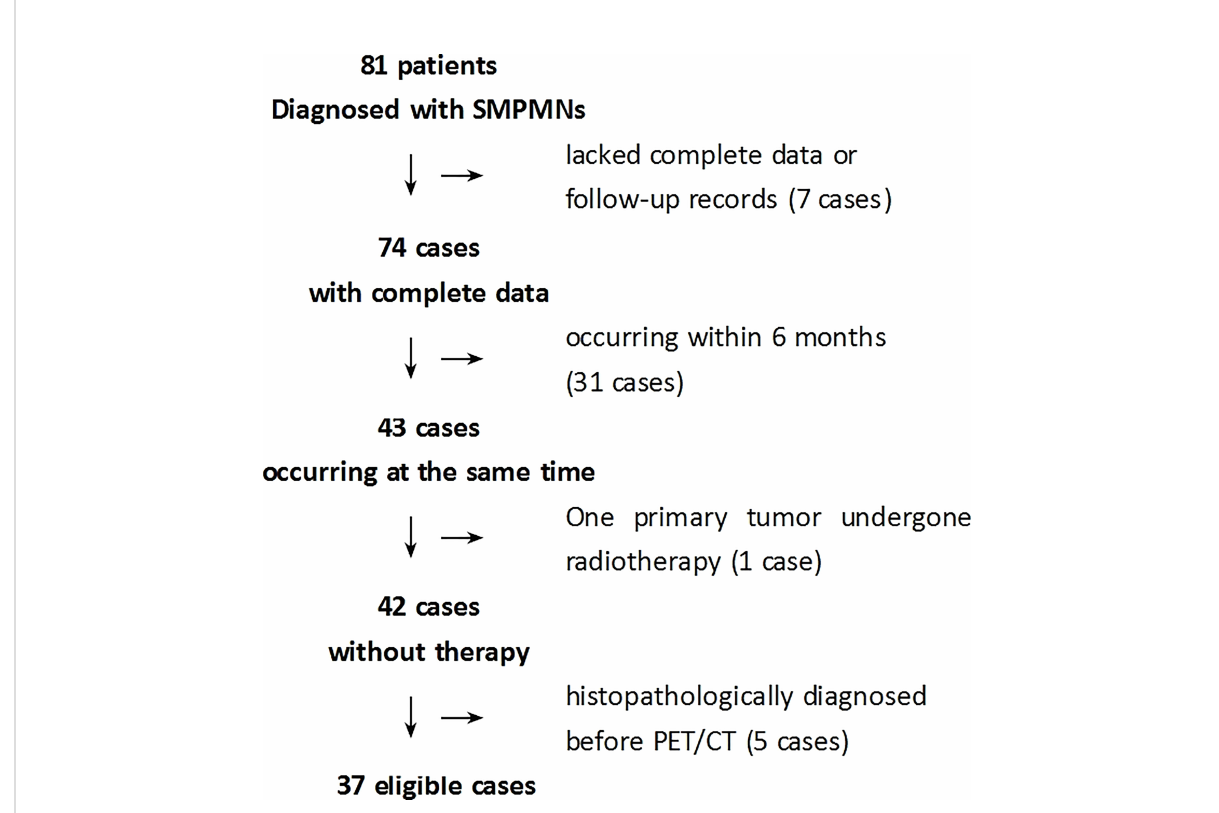
FIGURE 1 Flowchart of the selection of eligible patients. SMPMNs , synchronous multiple primary malignant